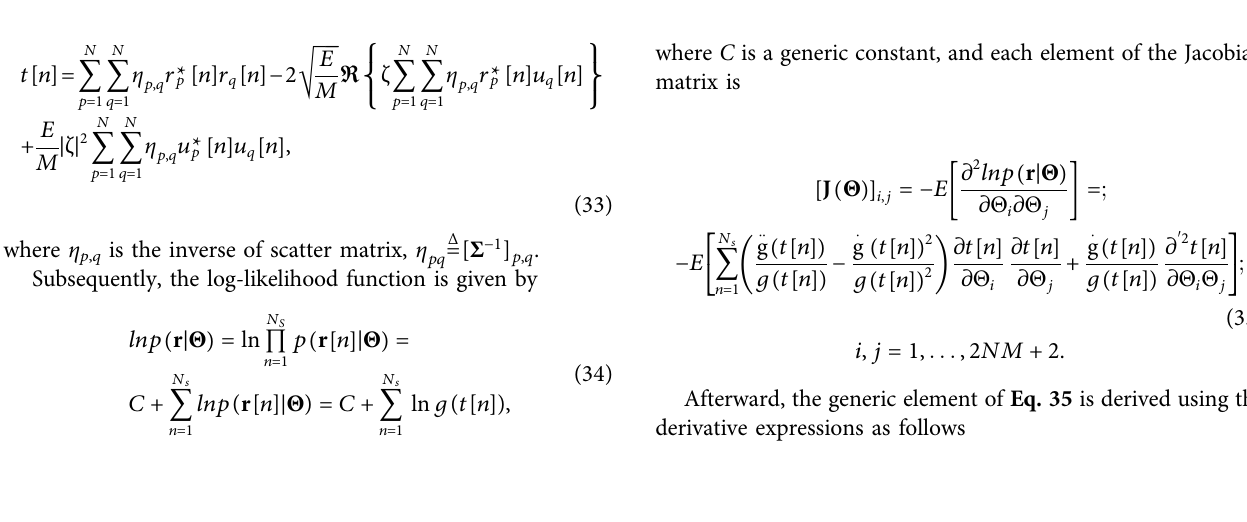
Frontiers in Signal Processing |